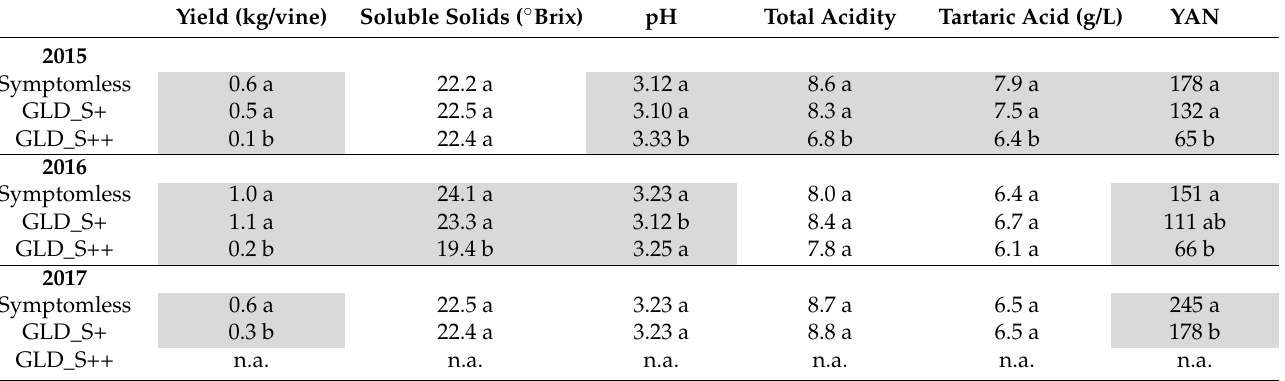
Table 3. Impact of grapevine leafroll disease on yield and fruit composition of V. vinifera cv. Pinot noir on rootstock 5BB over three consecutive years. Means within year followed by different letters differ significantly at p < 0.05 by Ducan’s new multiple range test. GLD_S+: Grapevine leafroll disease causing mild symptoms; GLD_S++: grapevine leafroll disease causing severe symptoms. Total (titratable) acidity is expressed in g/L of tartaric acid. YAN: yeast assimilable nitrogen (mg/L); n.a.: data not